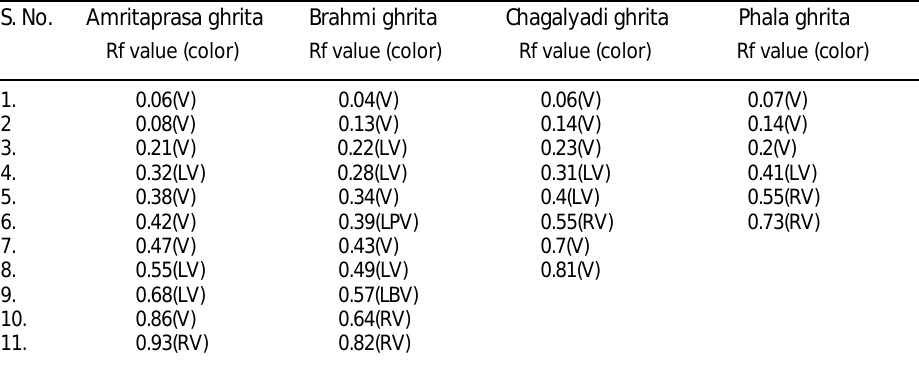
TABLE 3TABLE 3.. DATA OF TLC STUDY OF GHRITAS S. No.